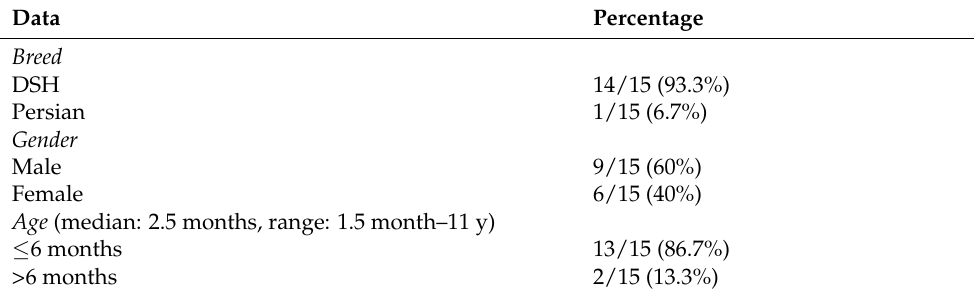
Table 5. Results of diagnostic tests in 15 cats with dermatophytosis.